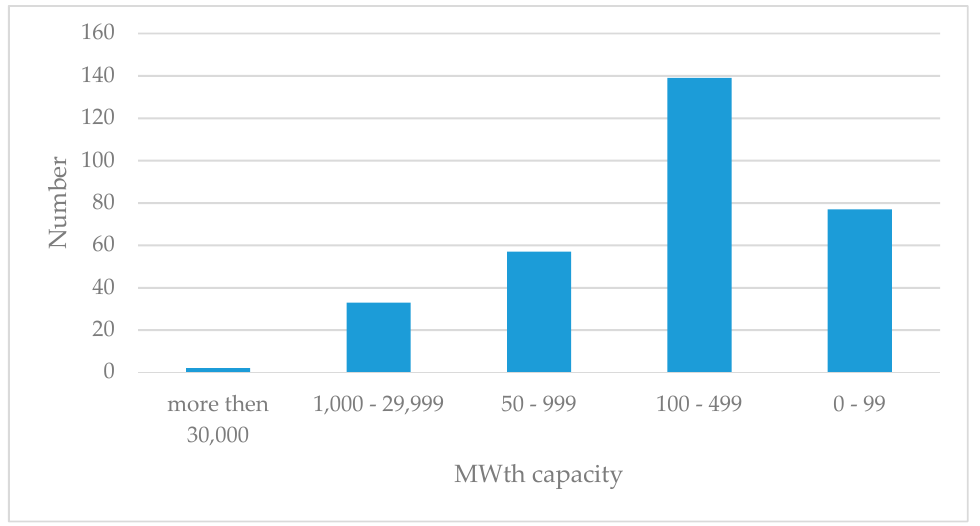
Figure 4. Distribution of industrial solar installations by size [23].